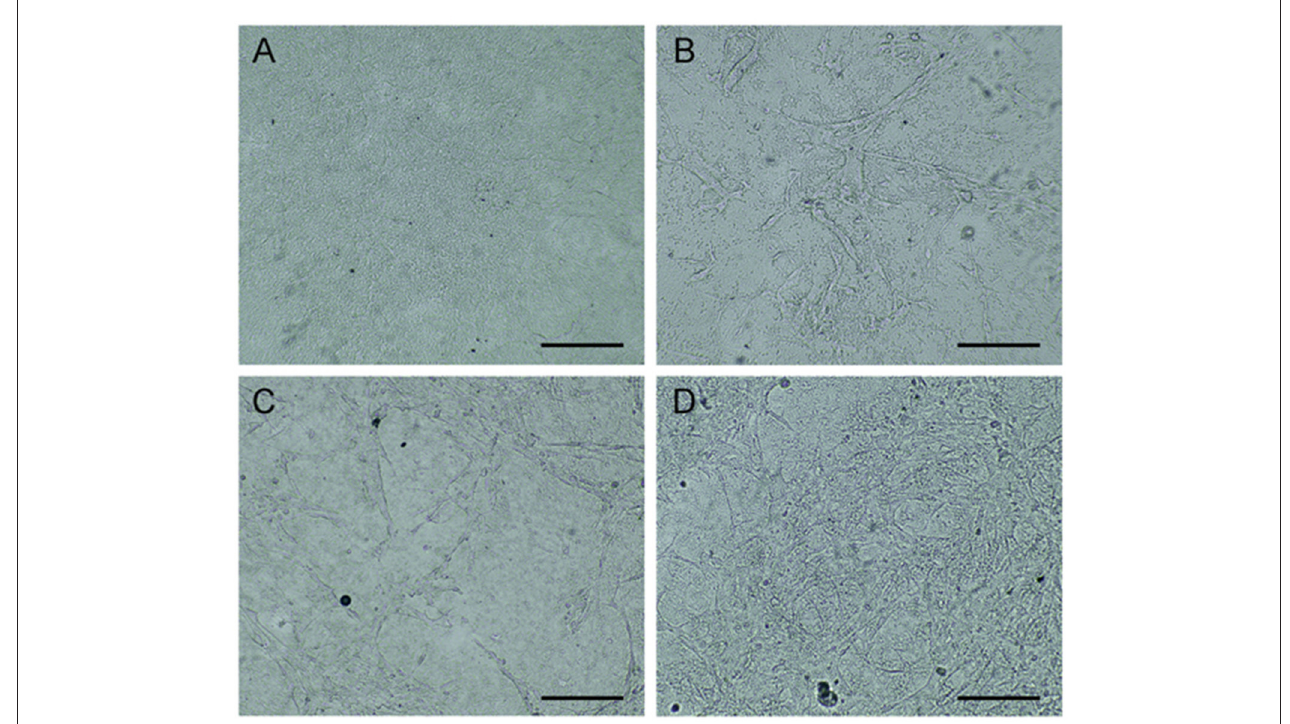
FIGURE 6 | Endothelial progenitor cells (EPCs) cultured on rMaSp/NaHS membrane till the density of 90%. (A) Optical microphotographs of rMaSp/NaHS membrane. (B–D) EPCs cultured on rMaSp/NaHS membrane on days 1, 3, and 7,